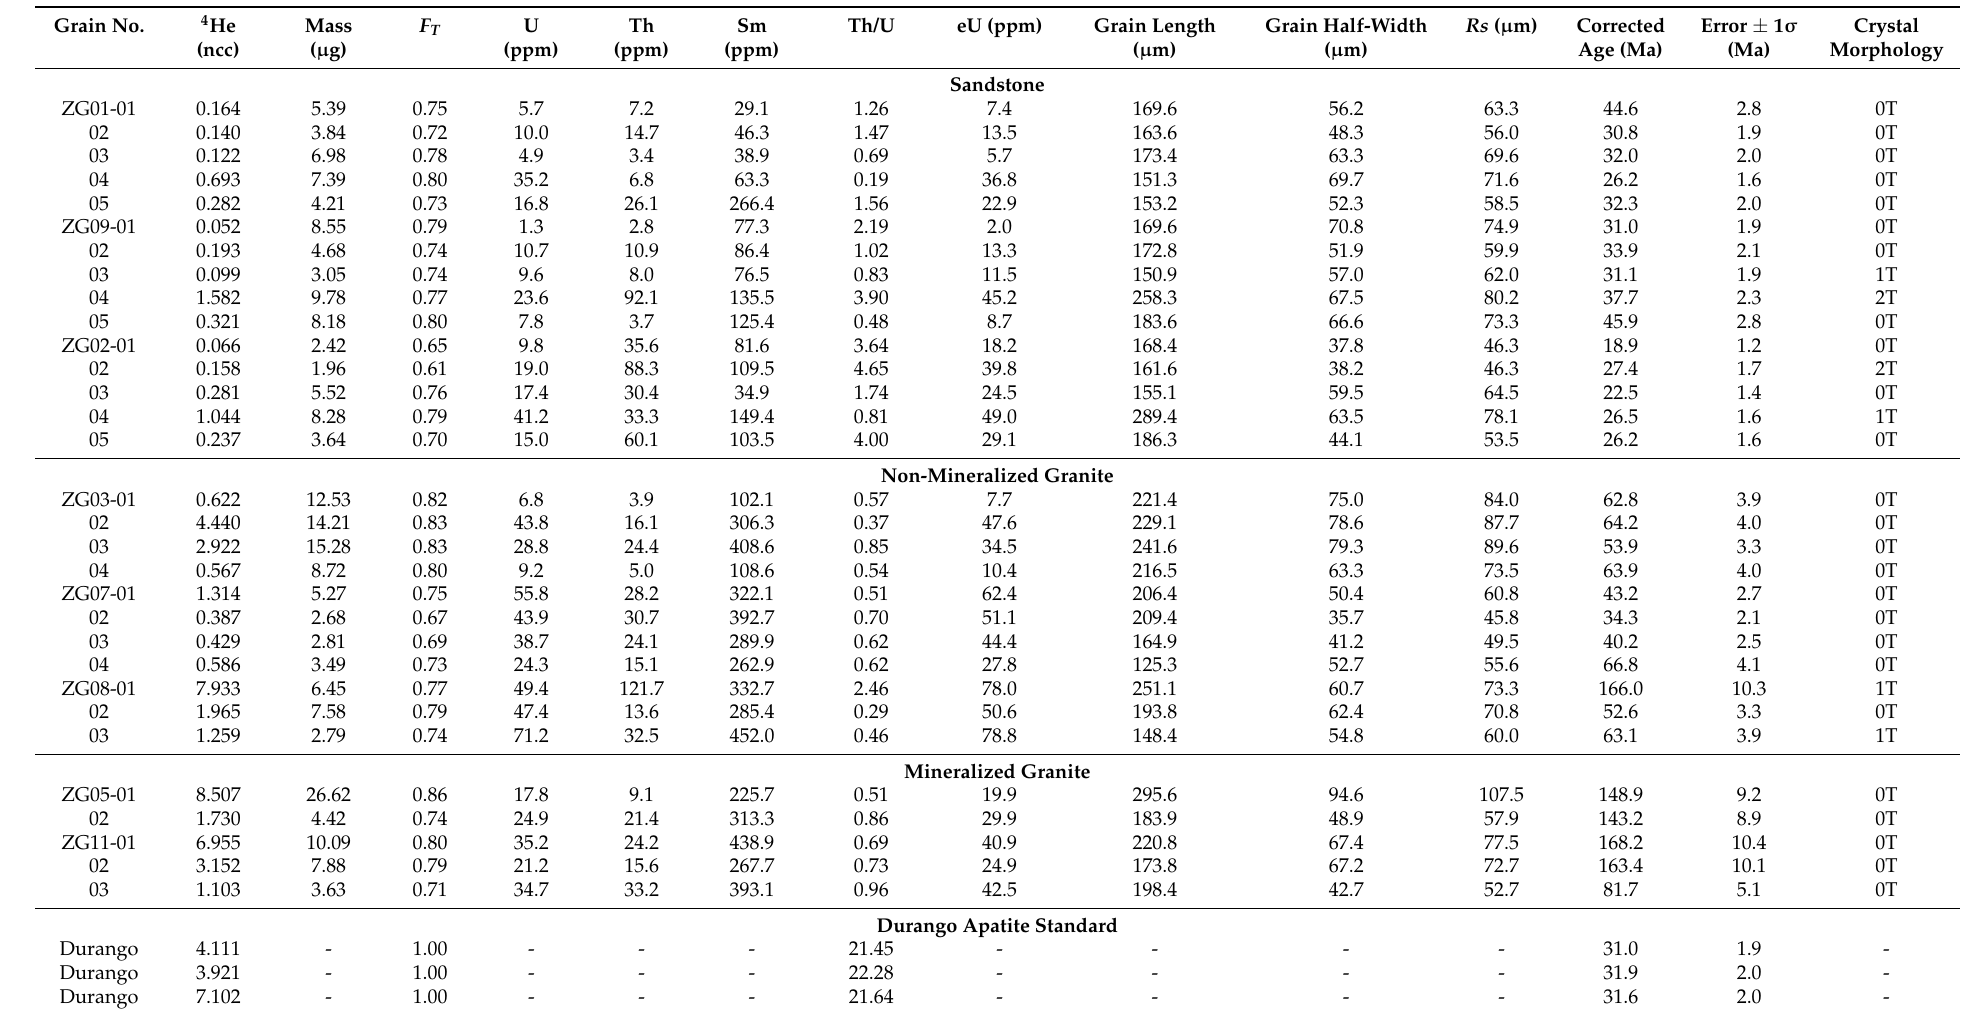
Table 4. Apatite (U-Th-Sm)/He data from the Lujing uranium ore field region, South China. Grain